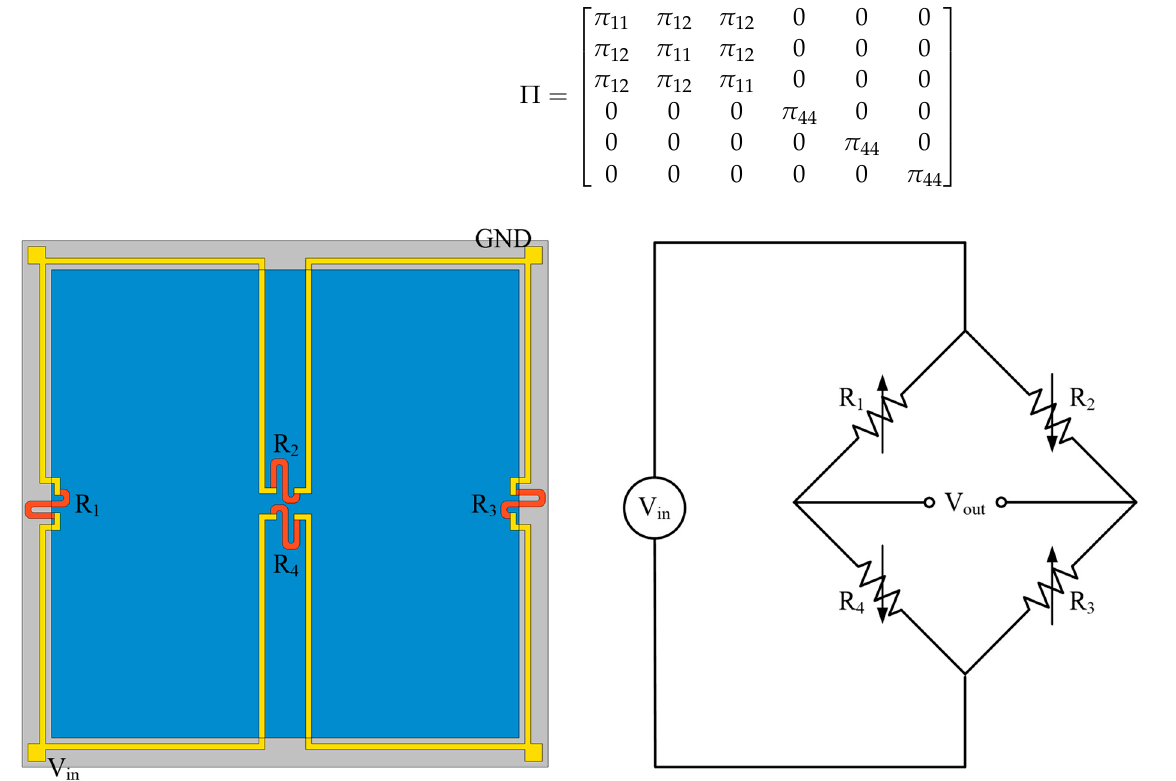
Figure 3. The positioning of four piezoresistors and Wheatstone bridge structure.